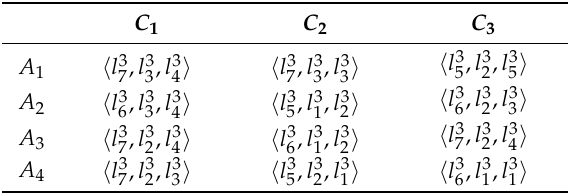
Table 4. The LNN decision matrix R 3 of the expert E 3